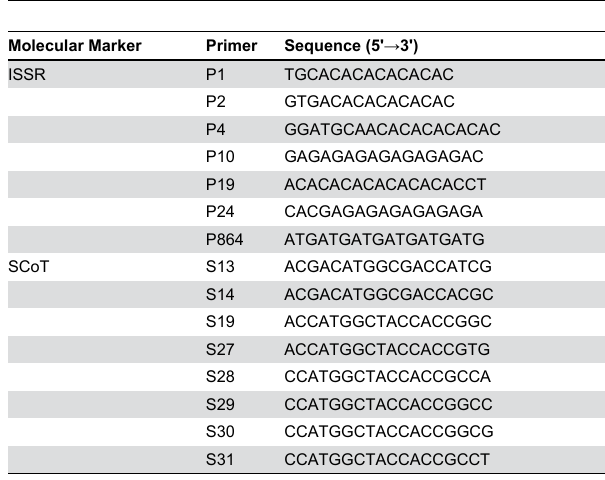
Table 2. ISSR and SCoT primer sequences for P. eryngii var. tuoliensis .